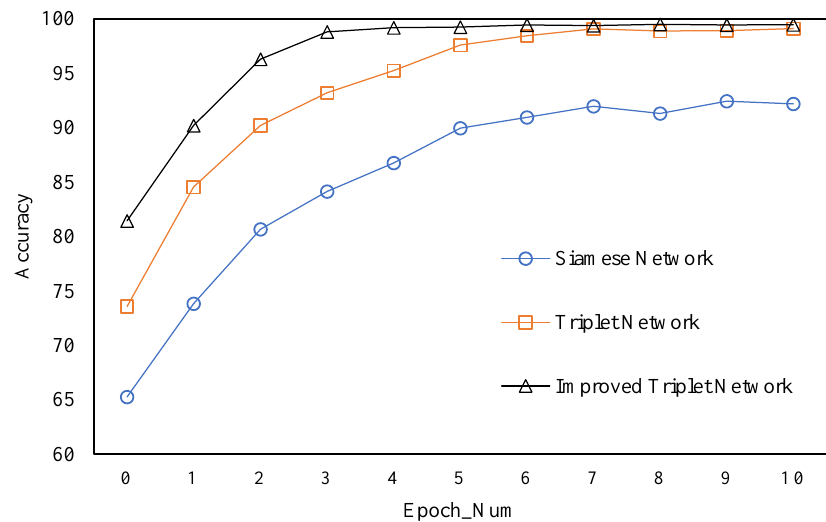
Figure 9. The classification accuracy of the three networks varies with the epoch number.